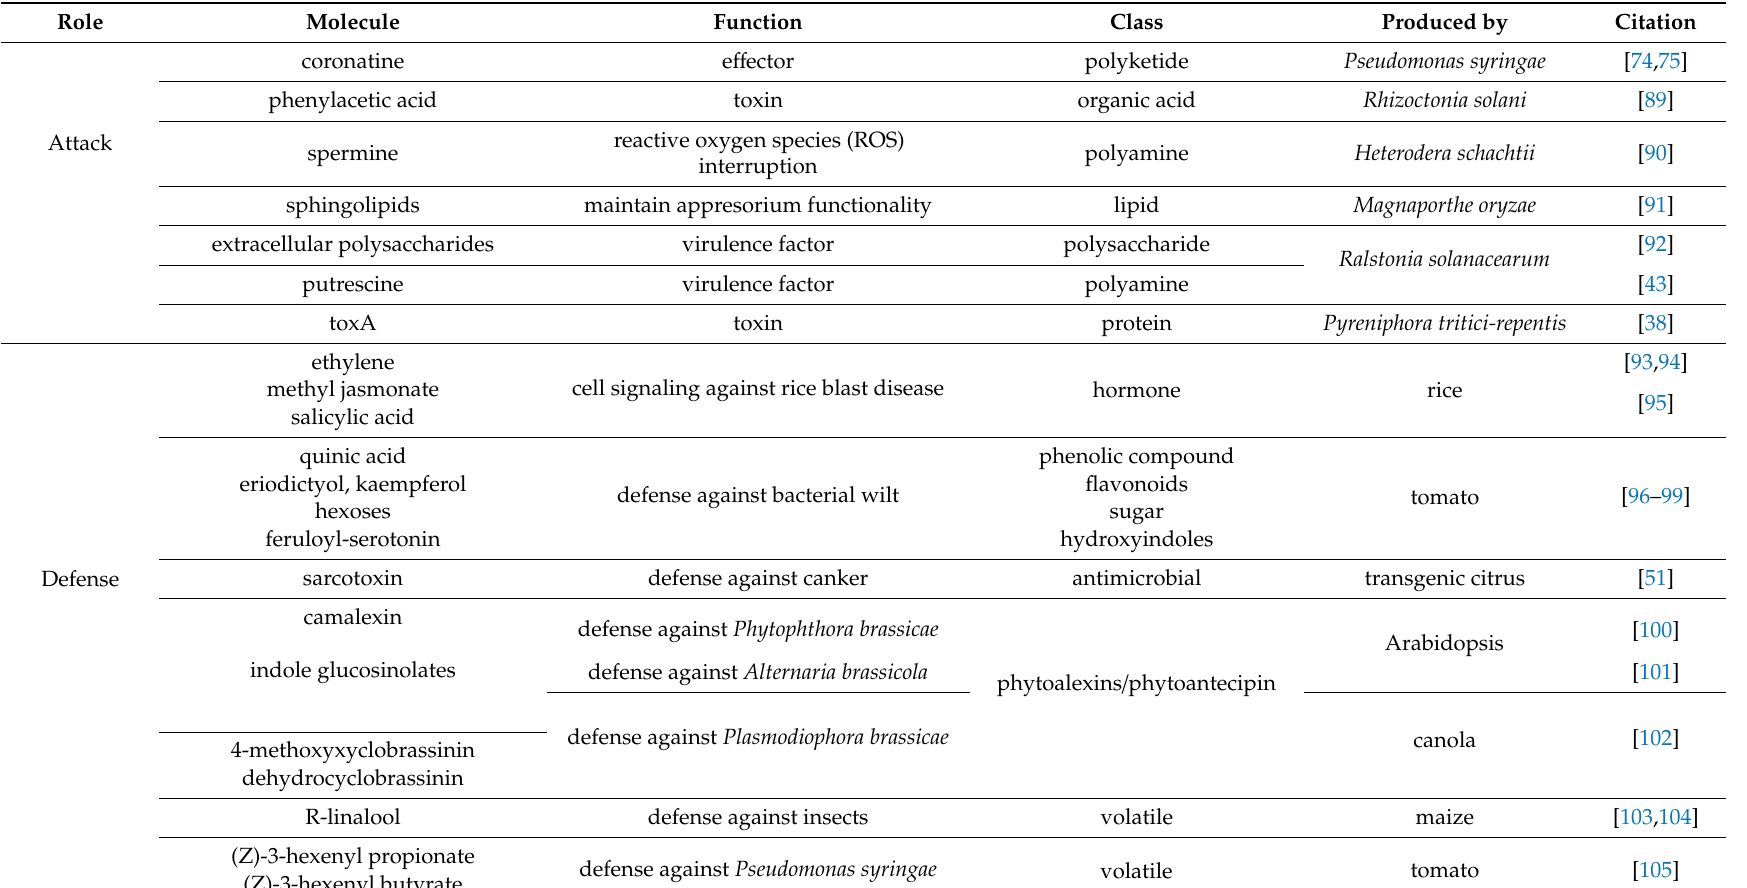
Table 1. Summary of metabolites cited in this study involved in plant–pathogen